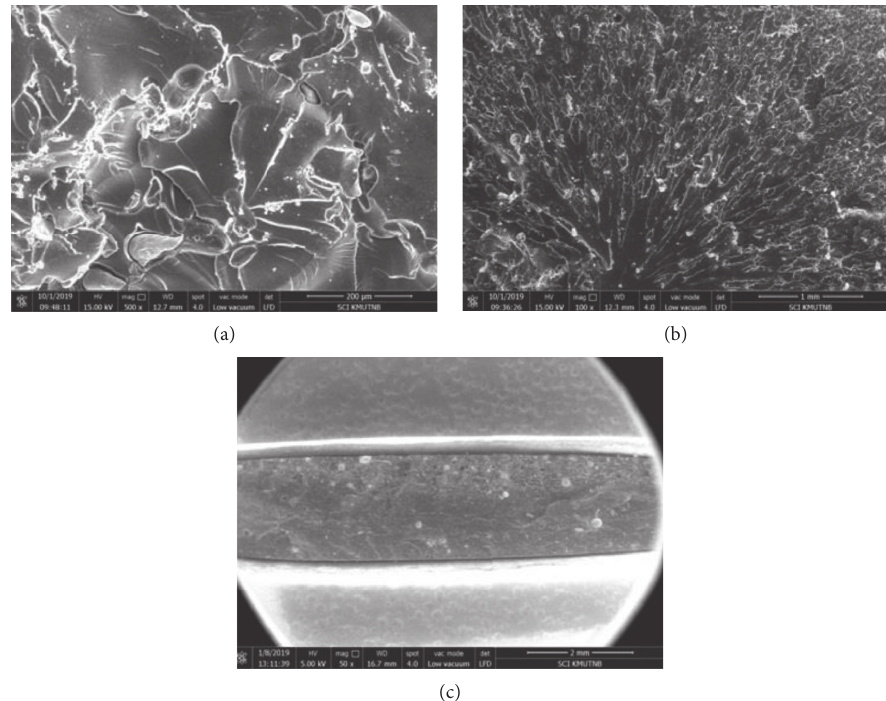
Figure 4: (a) SEM image depicting the agglomeration of dispersed particles. (b) SEM image depicting chevron pattern. (c) Delamination of trilayered specimen.